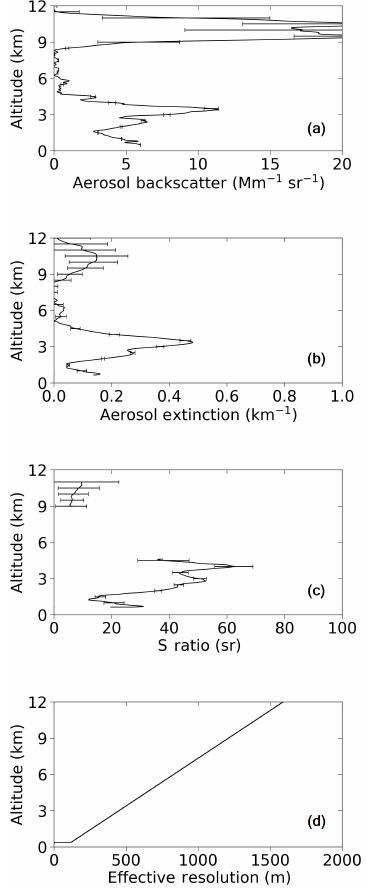
Figure 17. One-hour average between 08:00 and 09:00UTC on 31 August for (a) backscatter coefficient, (b) extinction coefficient, (c) S ratio and (d) effective